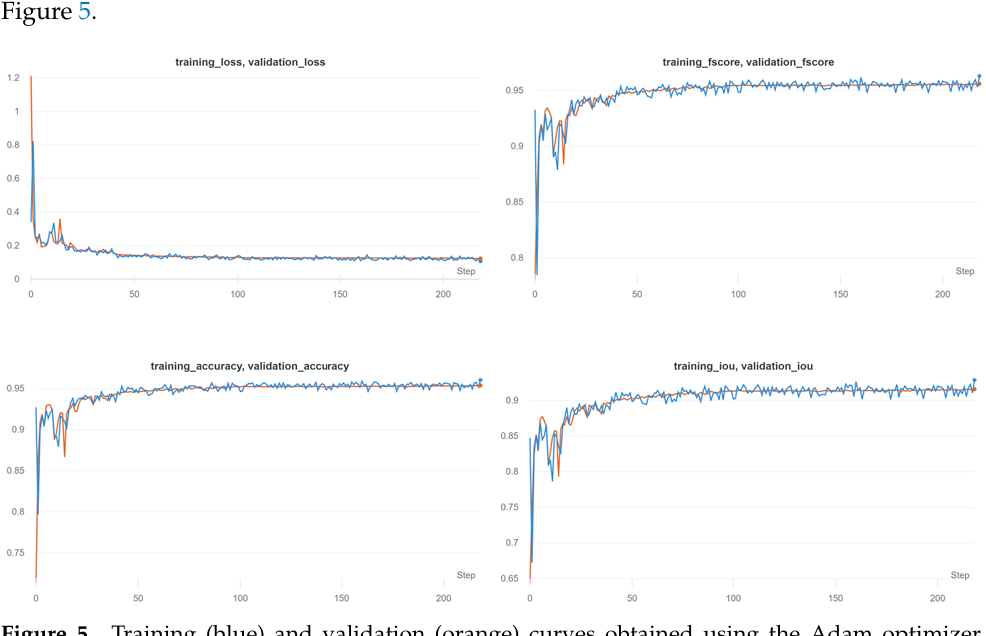
Figure 5. Training (blue) and validation (orange) curves obtained using the Adam optimizer. From top-left, clockwise, the four graphs represent the measures of loss, fscore, IoU, and accu- racy,